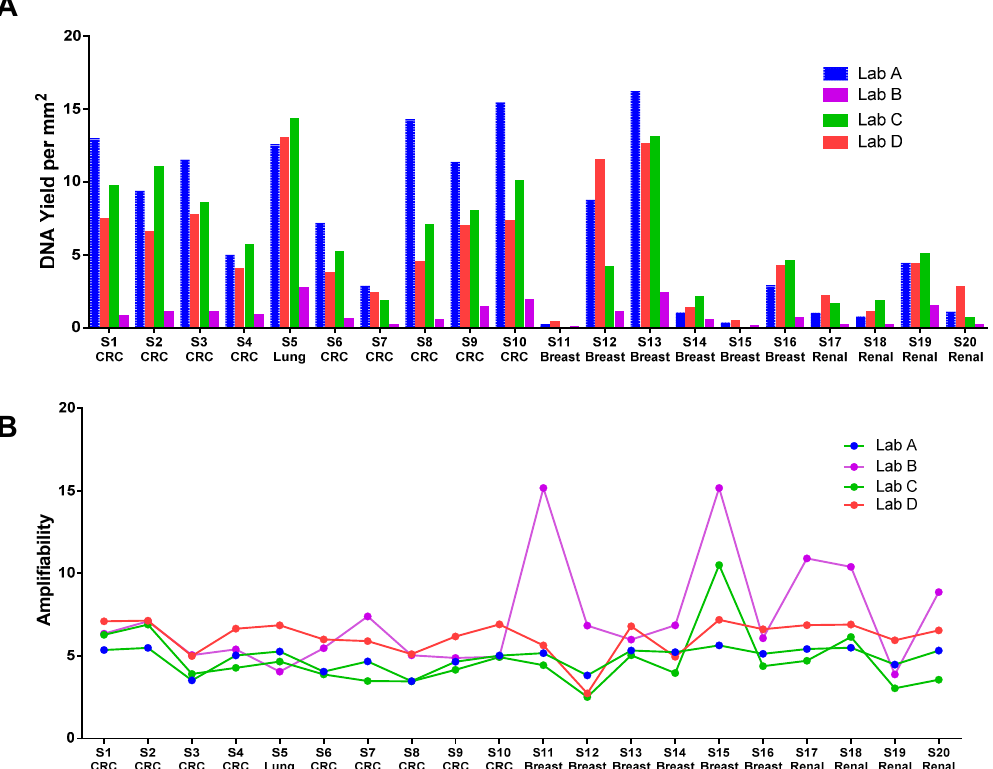
Figure 1. ( A ) DNA yield (ng/mm 2 tissue) from different labs. QIAamp FFPE kit (QIAGEN Cat# 56404, Hilden, Germany) was used by Labs A, C, D. RecoverAll (ThermoFisher Cat# AM1975, Waltham, MA, USA) was used by Lab B; ( B ) DNA amplifiability from different labs.